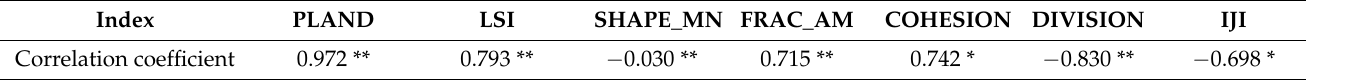
Figure 8. Results of Weights for Different Land Cover Types from 1995 to 2025. Table 3. Pearson’s Correlation Coefficients of ISLI and Selected Landscape Metrics.